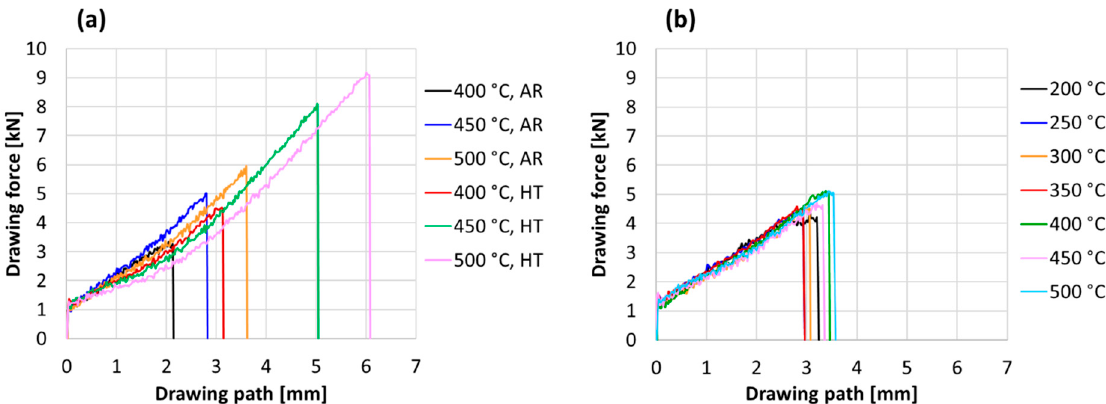
Figure 5. Drawing force—drawing path curves from Erichsen cupping tests at room temperature for ( a ) rolled sheets and ( b ) extruded bands. Table 3. Tensile properties at room temperature of the extruded bands tested along ED, TD (TYS, tensile 0.2% yield stress; UTS, ultimate tensile stress; ε u , uniform elongation; ε f , elongation to